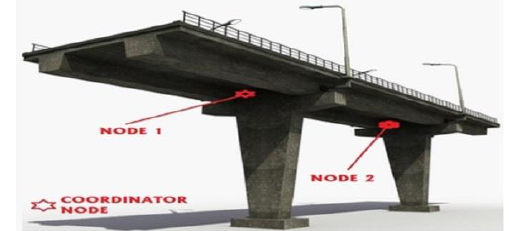
Figure 2. SHM systems of presumed bridge and layout of its components [7].